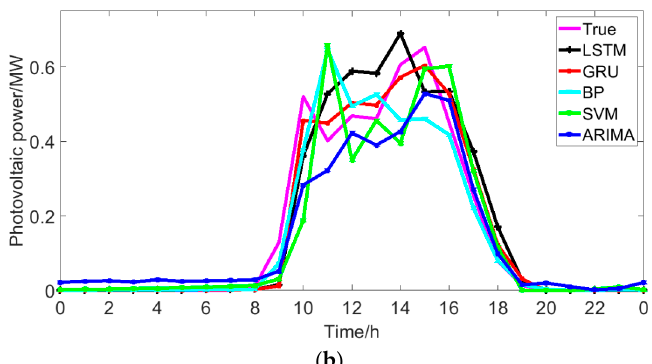
Figure 8. The performance of each method RMSE of each method. ( a ) The RMSE of each method; ( b ) Photovoltaic power of 28 June 2014.